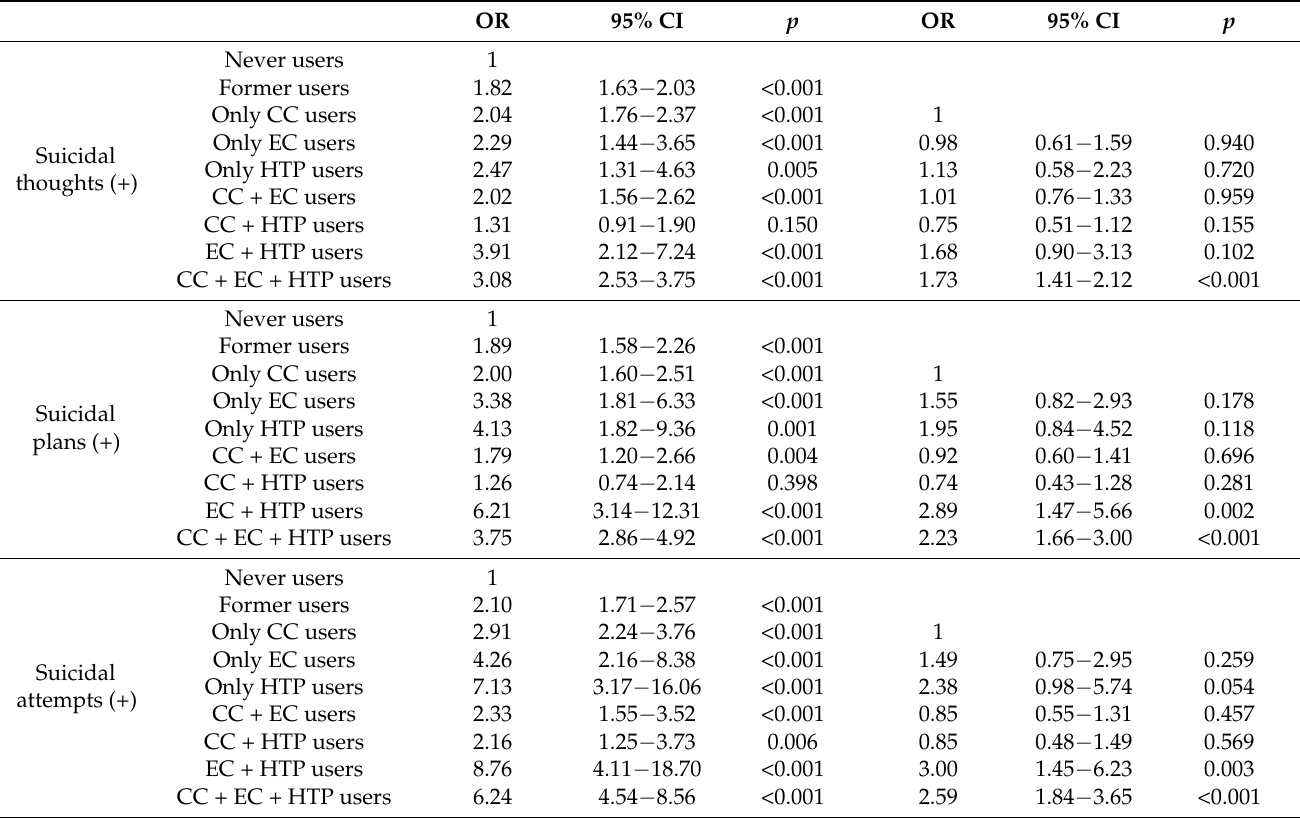
Table 3. Association of the type of cigarette with suicidal